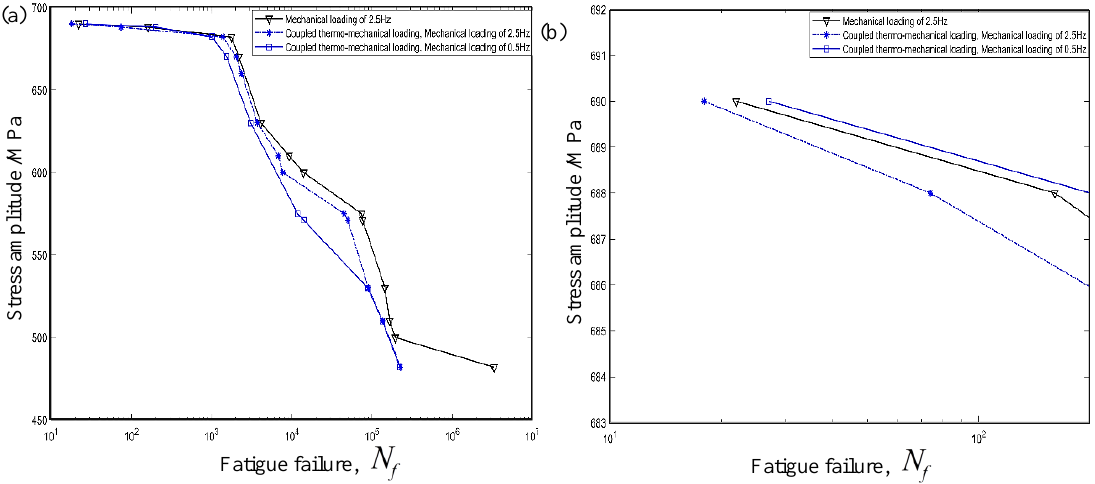
Figure 7. Fatigue life of composite laminates under thermo-mechanical loading at room temperature. ( a ) Temperature cycling effects. ( b ) Partial enlargement graph.